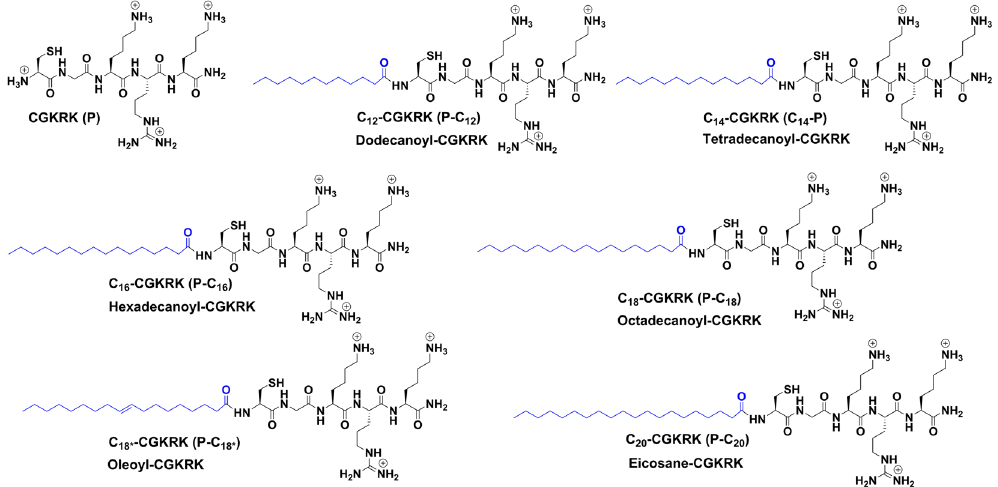
Figure 1. Chemical structures of synthesized fatty acyl-peptide conjugates used in this